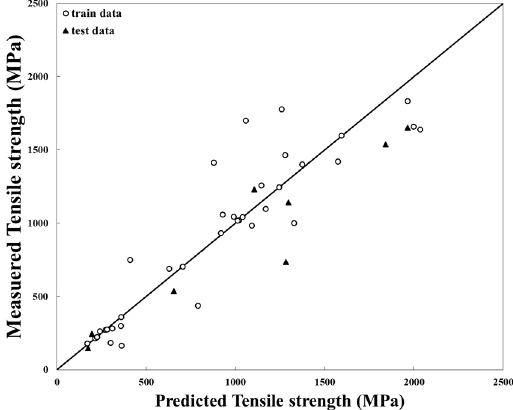
Figure 2. Accuracy of an ANN model trained with elemental mole fraction and process data.